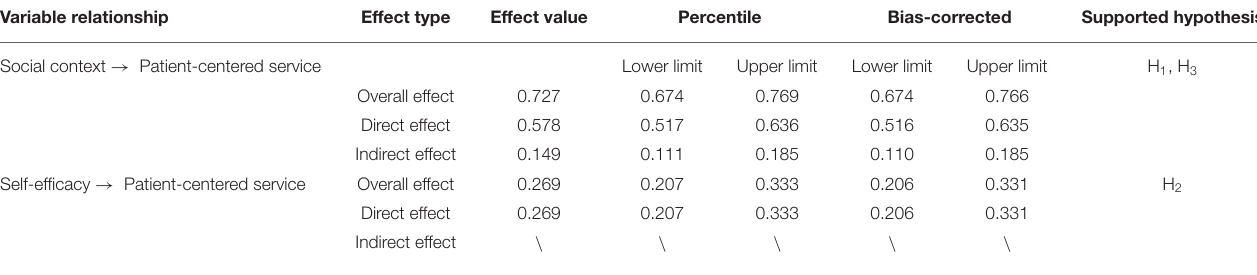
TABLE 5 | Bootstrap confidence interval estimation